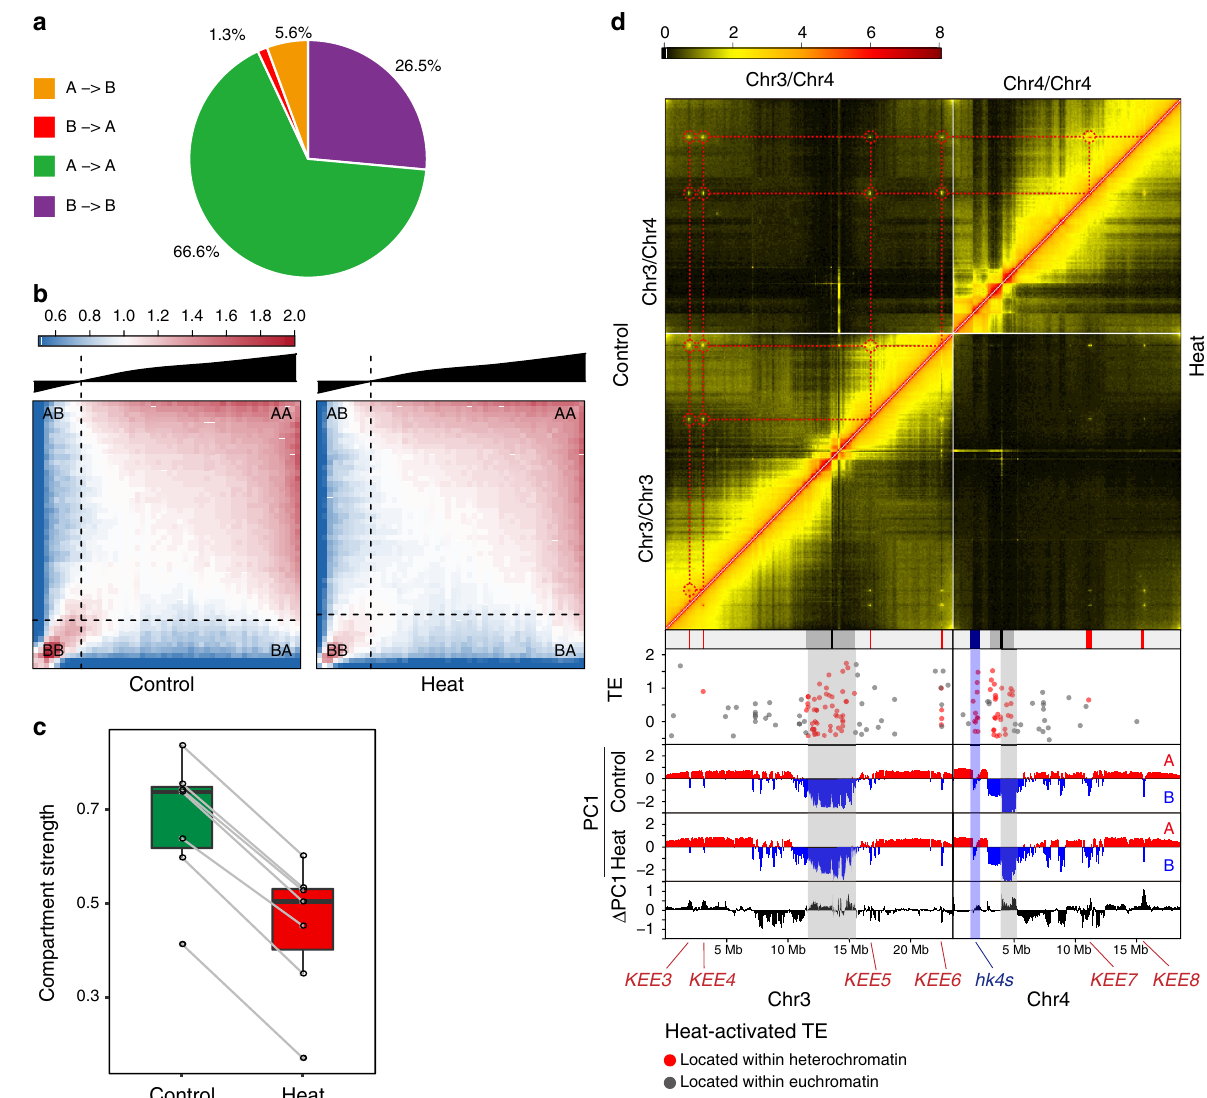
Fig. 4 Heat weakens chromatin compartmentation. a Pie chart showing the percentages of chromatin compartment switching induced by heat. A compartment: active compartment; B compartment: repressive compartment. b Saddle plots of chromatin compartmentalization: mean cis observed interaction frequencies divided by expected interaction frequency between 20 kb bins. The plots are ordered by PC1 values from Control. Interactions between A compartments are in the top right, and interactions between B compartments are in the bottom left. c Compartment strengths in Control and Heat for each chromosome arm split by centromere. Compartment strength is de fi ned as natural logarithm of interactions of AA + BB normalized by interactions of AB. For the box plot, center lines indicate the medians; boxes show the 25th and 75th percentiles; whiskers extend to the minimum and maximum. d Heatmap showing contact frequencies between and within chromosomes 3 and 4 in Control and Heat. The upper- and lower-triangular matrices correspond to Control and Heat, respectively. The values on the diagonal line (interactions between nearby bins) are assigned to zero. The KEEs are highlighted by dashed, red circles and interconnected by dashed lines to indicate the relationships with each other and the positions of KEEs in the linear genome. The track below shows the positions of centromeres (black), pericentromeres (gray), the knob hk4s (blue), and KEEs (red). The lower panel shows the positions and differential expression of heat-activated TEs within chromosomes 3 and 4, PC1 values in Control condition, PC1 values in Heat condition, and Δ PC1 values (PC1 Heat − PC1 Control ) horizontally. The positive PC1 values indicate A compartments. The negative PC1 values indicate B compartments. The positions of pericentromeres and the knob hk4s with increased PC1 values are indicated. Source data underlying a and d are provided as a Source Data fi